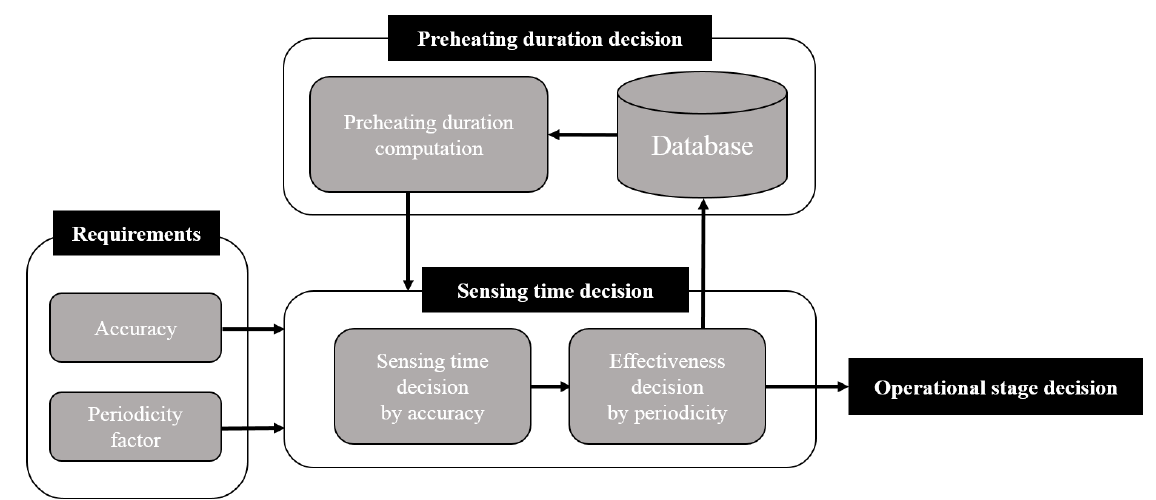
Figure 1. Overall block diagram of the APC